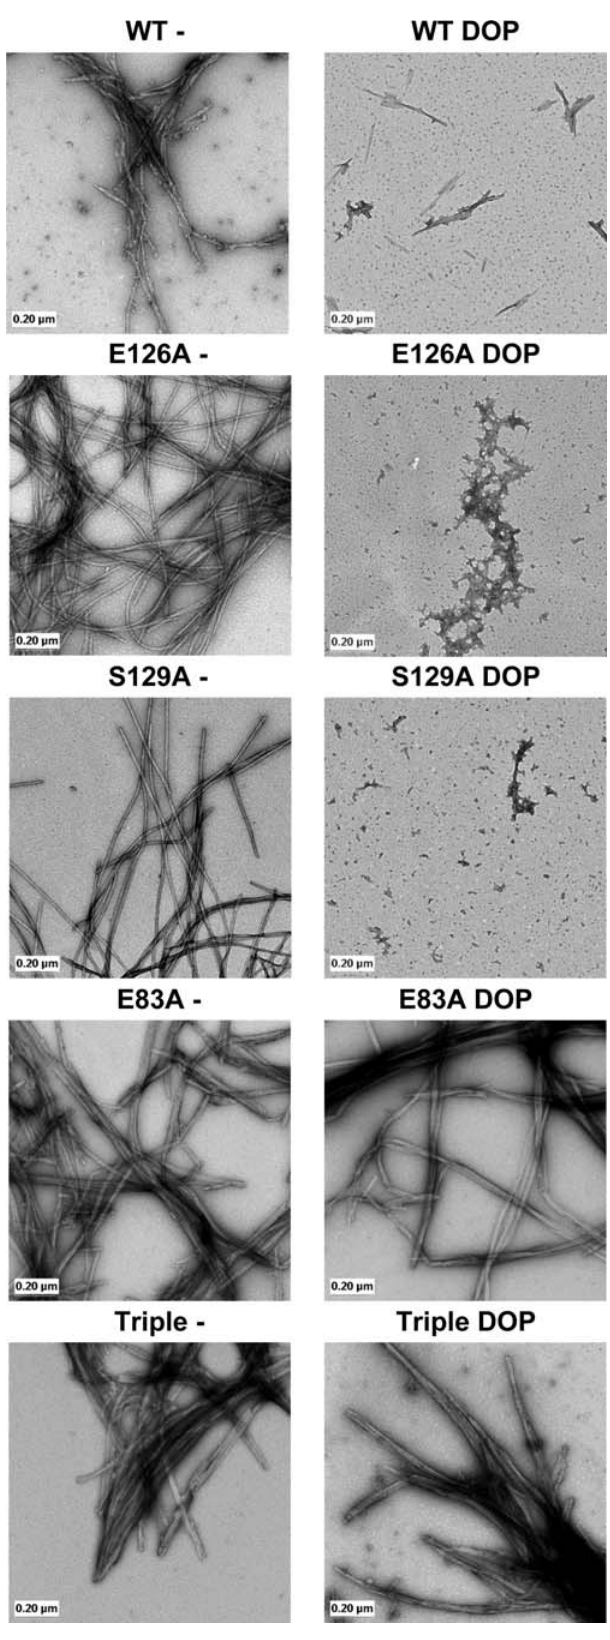
Figure 4. TEM analysis: WT and mutant a -synuclein (E83A, E126A, S129A and Triple) filament assembly in absence or presence of an equimolar quantity of dopamine (DOP). Proteins were incubated under assembly conditions for 72 hrs and analyzed by negative staining EM as described in Materials and Methods.